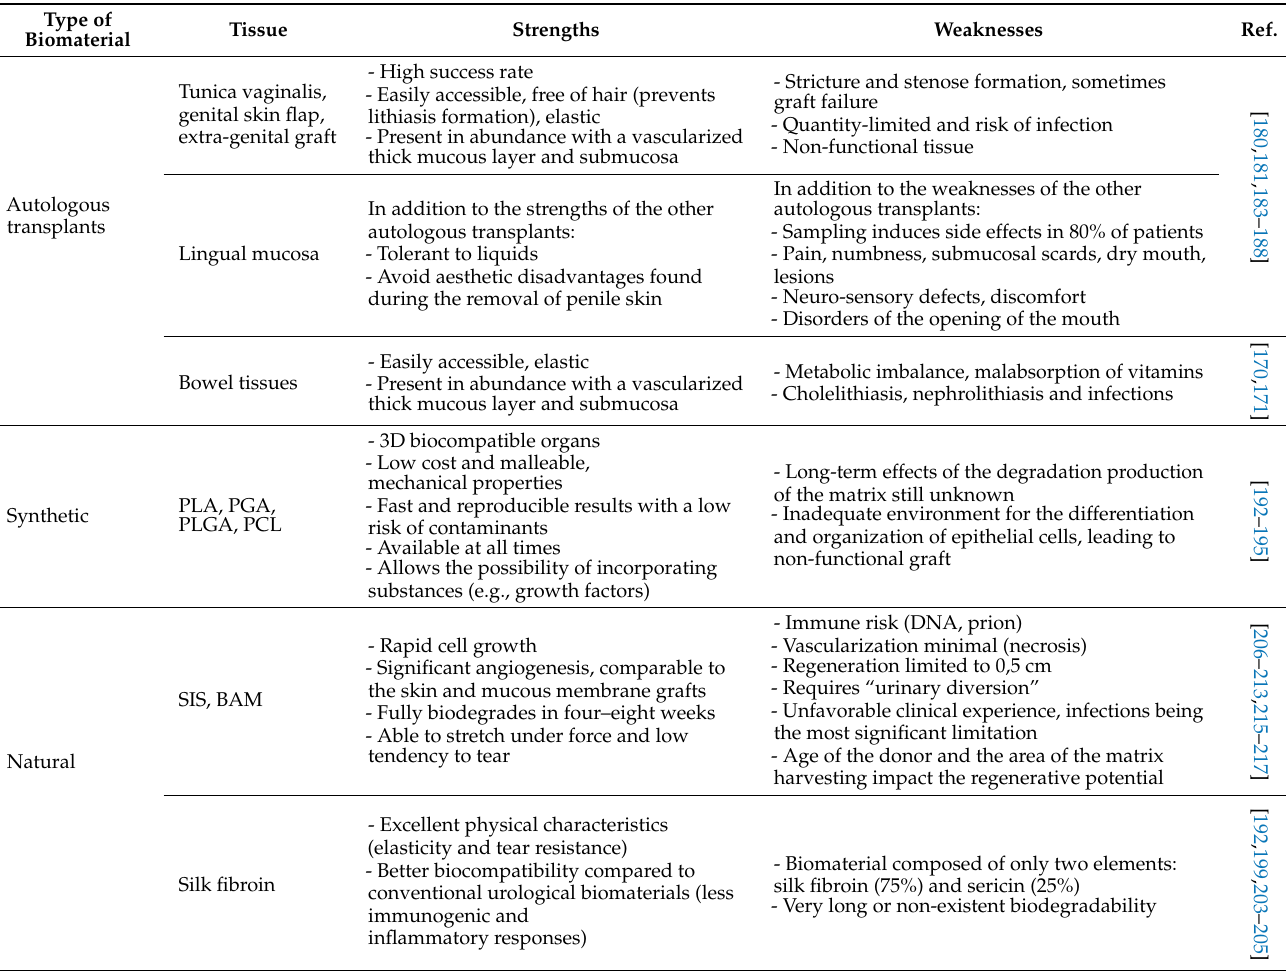
mouse red blood cells inside the human endothelial network demonstrated its functionality. Table 2. Strengths and weaknesses of the transplants or biomaterials used for both ureteral and urethral reconstruction. Type of Tissue Strengths Weaknesses Biomaterial